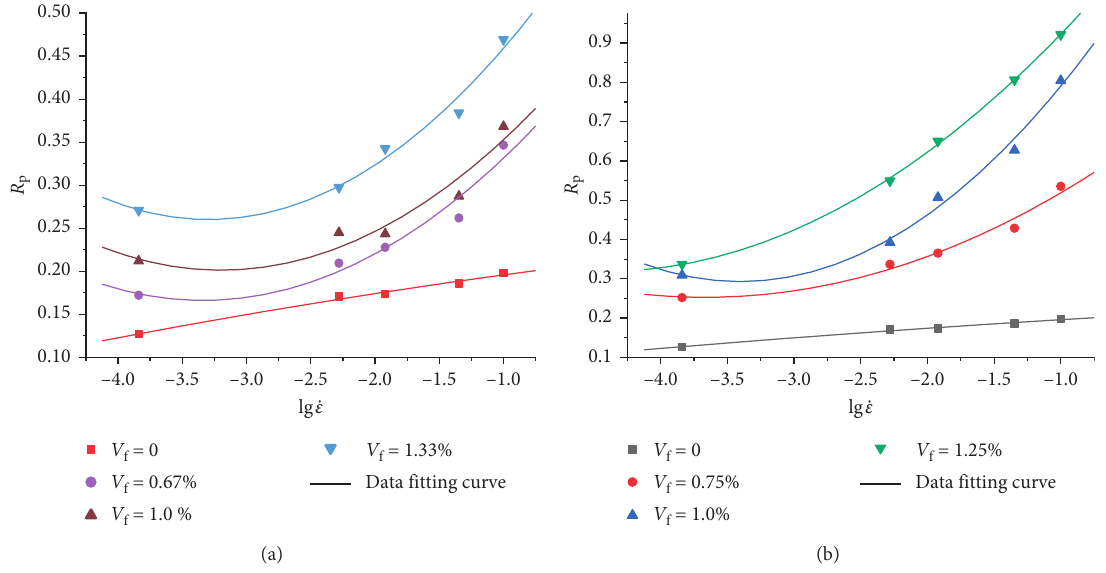
_ ε of SFRC. p and lg